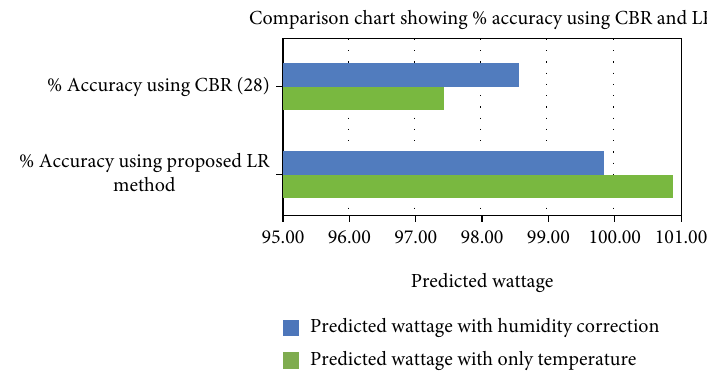
Figure 19: Comparison chart showing % accuracy obtained using CBR and